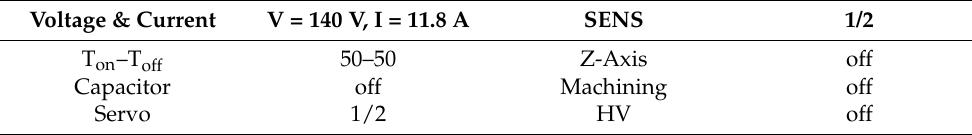
Table 5. Parameter settings of the EDM.